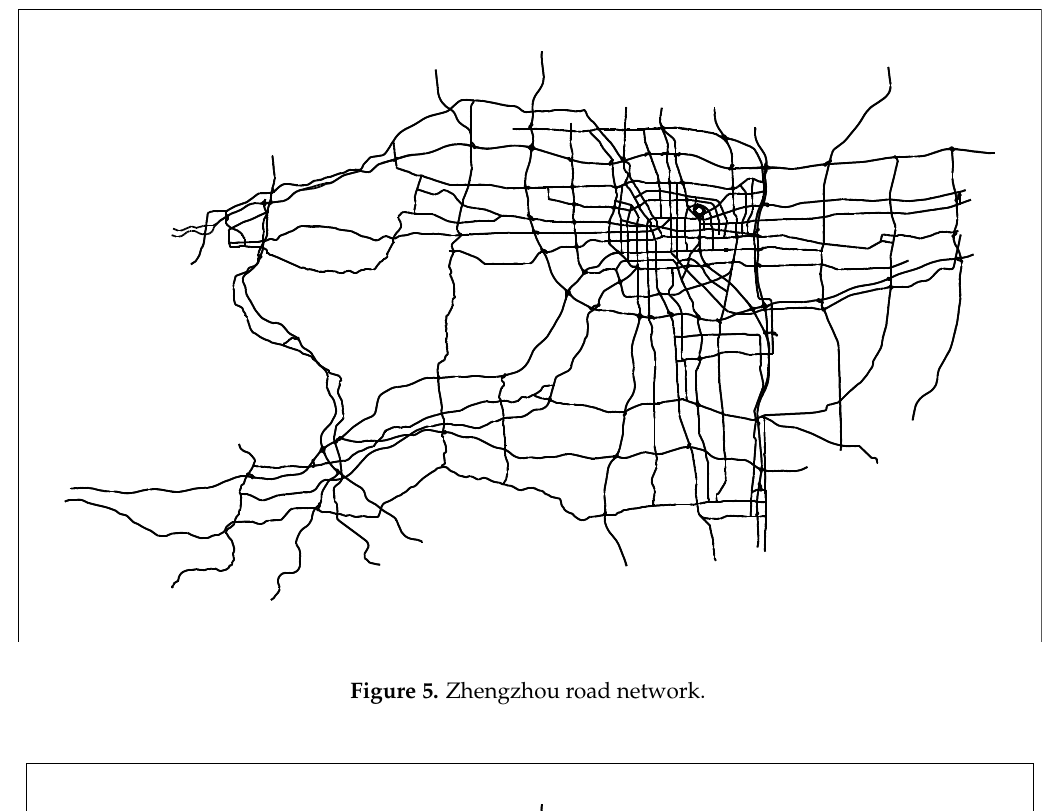
Figure 5. Zhengzhou road network.